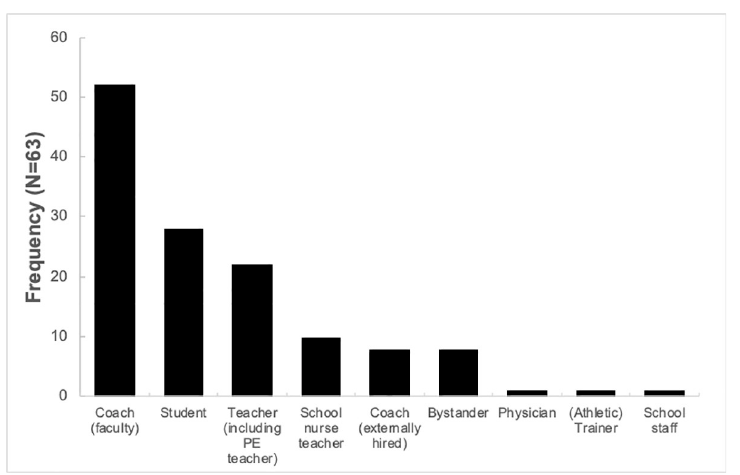
Fig 4. Distribution of first responder by type reported in 63 confirmed sports-related catastrophic events reported to Japan Sports Council.